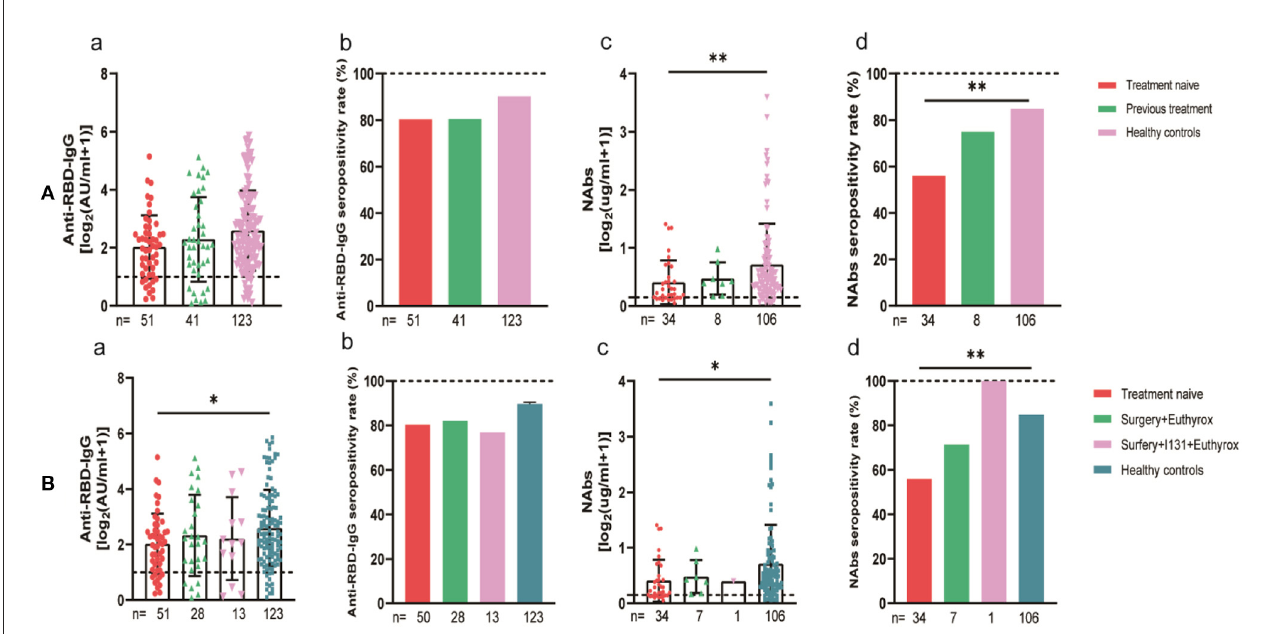
FIGURE11 Antibody response to SARS-CoV-2 vaccine in thyroid cancer patients with different treatments. (A) Antibody responses to SARS-CoV-2 vaccines in thyroid cancer patients with or without treatment. (B) Antibody responses to SARS-CoV-2 vaccines in thyroid cancer patients with or without Surgery and (or) I131 treatment. Subgroup analysis of the titers and seropositivity rate of anti-receptor binding domain (RBD)-IgG (a, b) and NAbs (c, d) in participants according to different treatments. The horizontal dotted lines represent the limit of detection. The error bars represent the median (IQR) (* P < 0.05, ** P < 0.01). NAbs, neutralizing antibodies; IQR, interquartile range; RBD, receptor binding